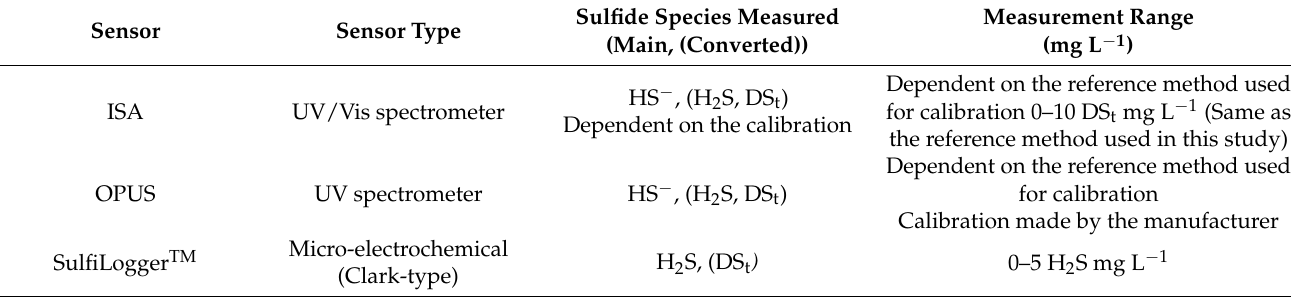
Table 1. The liquid phase sensors type, sulfide fractions measured, and measurement range.